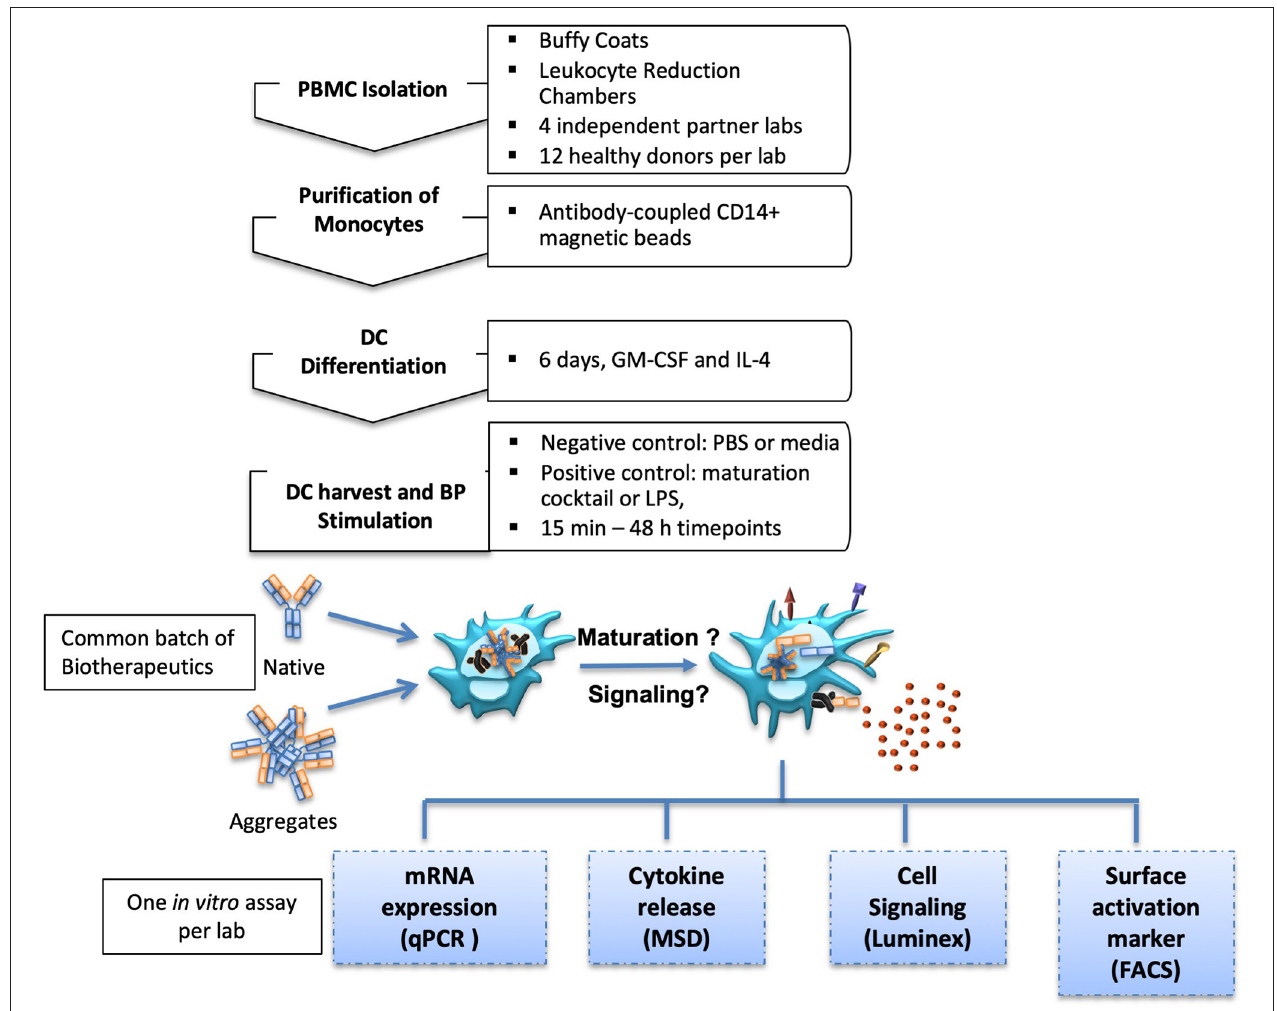
FIGURE 1 | Experimental setup. MoDC isolation and differentiation protocols were aligned for four international partner laboratories. Generated moDC cultures were treated with native or aggregated forms of Abs. MoDC maturation was measured by different in vitro assays.